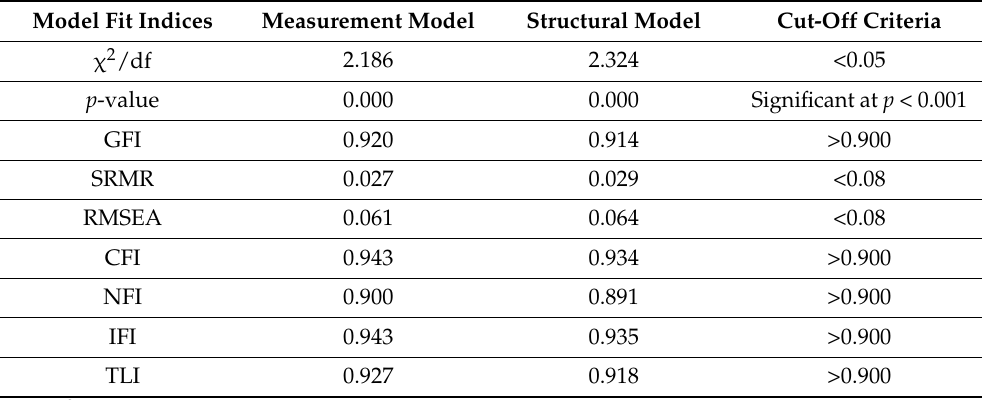
Table 8. Measurement and structural model fit indices.